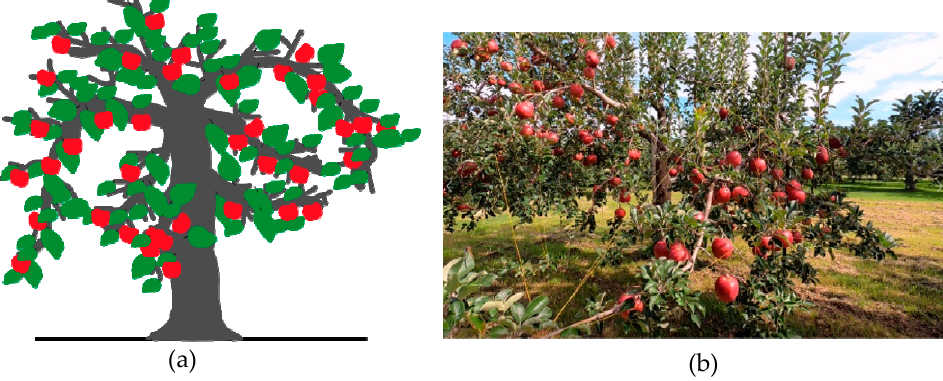
Figure 1. ( a ) Conventional tree structure with complex distribution of branches and ( b ) real conventional apple orchard conditions (Aomori Prefectural Industrial Research Center, Research insti ‐